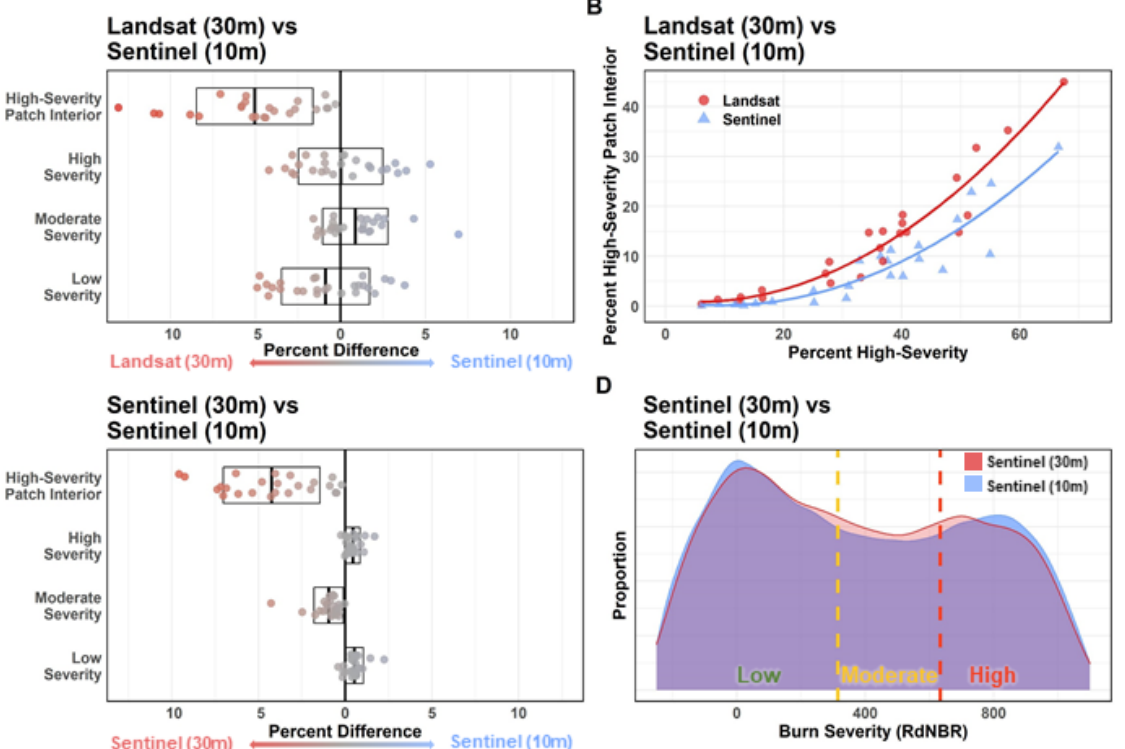
Figure 2. Differences in the proportion of forest-classified pixels among the mapped fires for three severity classes (low, moderate, and high) and as high-severity patch interior (high-severity pixels >90 m from the nearest low or moderate severity pixel). Severity classes were derived from RdNBR calculated using the extended composite approach (see Section 2.4), and the difference in percent estimated for each class is shown between Landsat and Sentinel ( A ), and Sentinel at 10 m resolution and resampled to 30 m resolution ( C ). Each dot represents one of the 26 fires (the two smallest fires were excluded for the high-severity patch interior), and the bars show the mean ±1 standard devi- ation. The relationship between percent high severity and percent high-severity patch interior for each fire is shown as mapped by Landsat (red circle) and Sentinel (blue triangle) ( B ). Frequency plots of the continuous RdNBR values for the Hayes Two fire are overlaid as mapped by Sentinel at 10 m resolution (blue) and 30 m resolution (red), with the vertical dashed lines depicting the cate- gorical breaks between low/moderate severity and moderate/high severity ( D ).